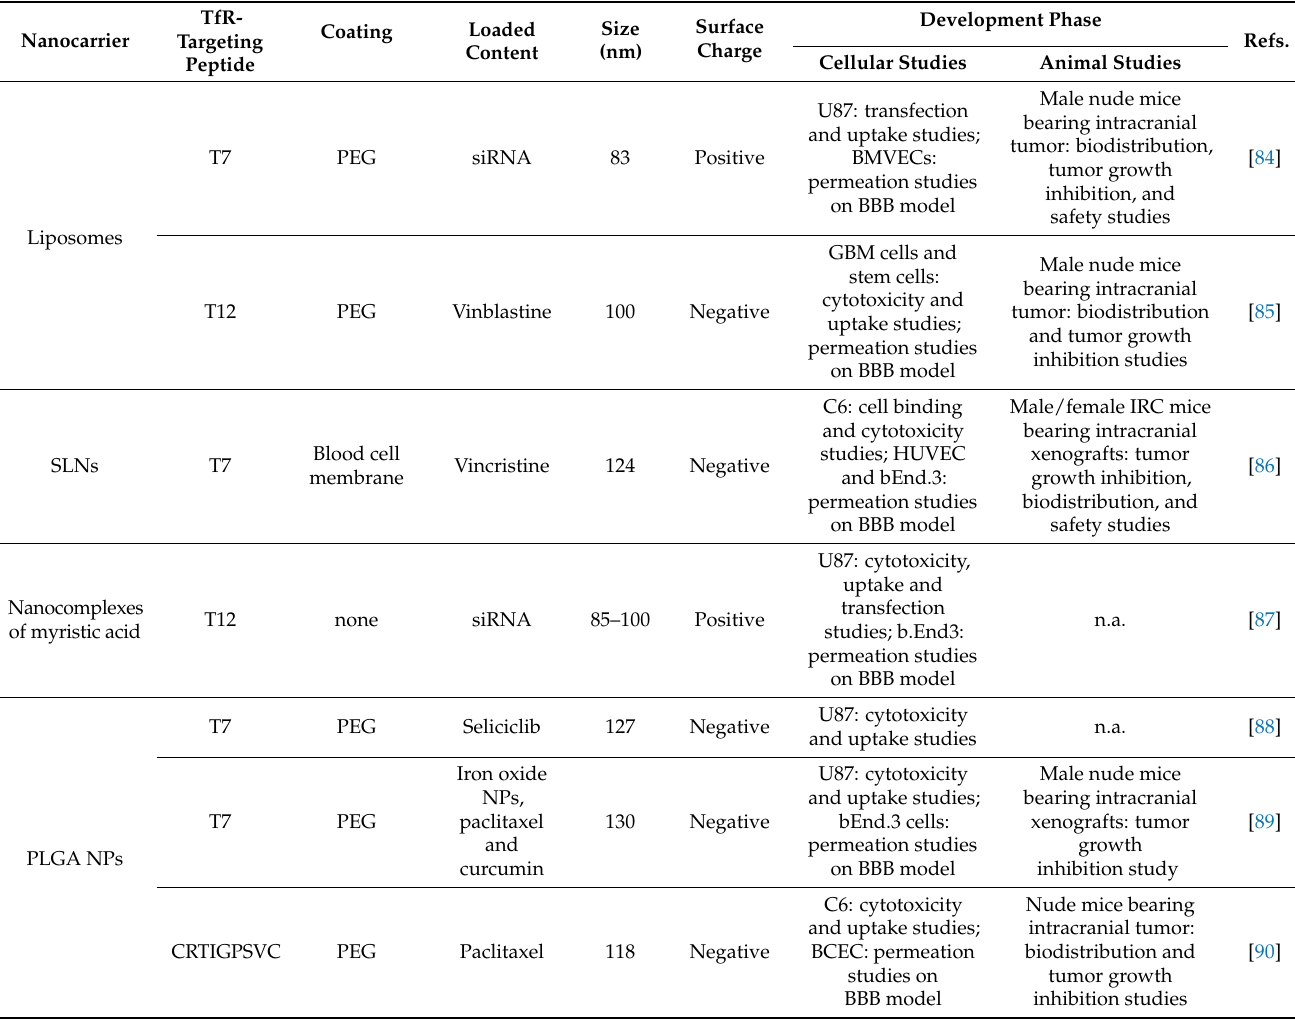
Table 4. Currently developed nanosystems modified with TfR-targeting peptide for GBM